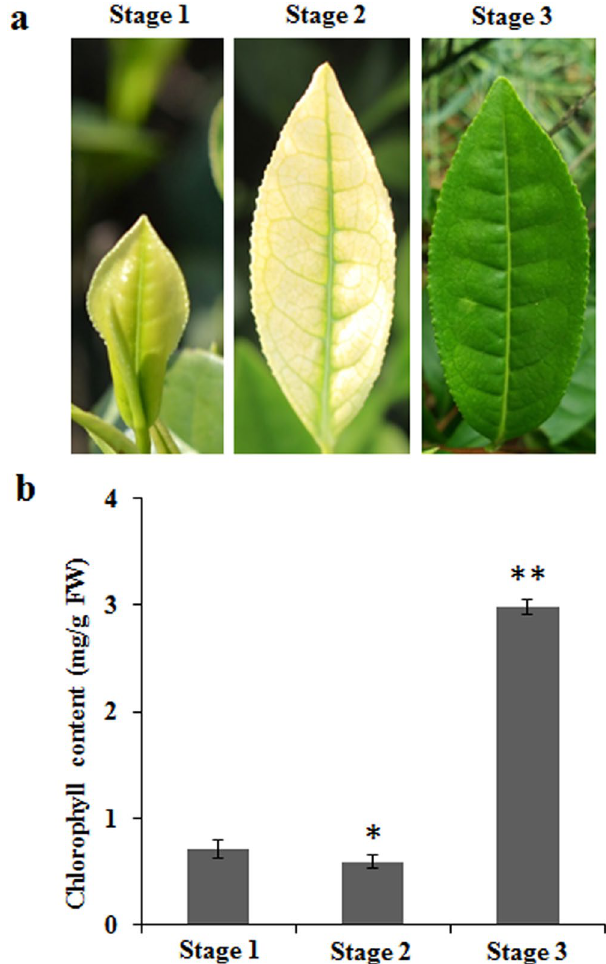
Figure 1. ‘Anji Baicha’ leaves and chlorophyll concentrations during three developmental stages. ( a ) ‘Anji Baicha’ leaves. ( b ) Chlorophyll concentrations. All experiments were analysed using five independent biological replicates. * Indicates a significant difference at P < 0.05, and ** Indicates a significant difference at P < 0.01 (Student’s t